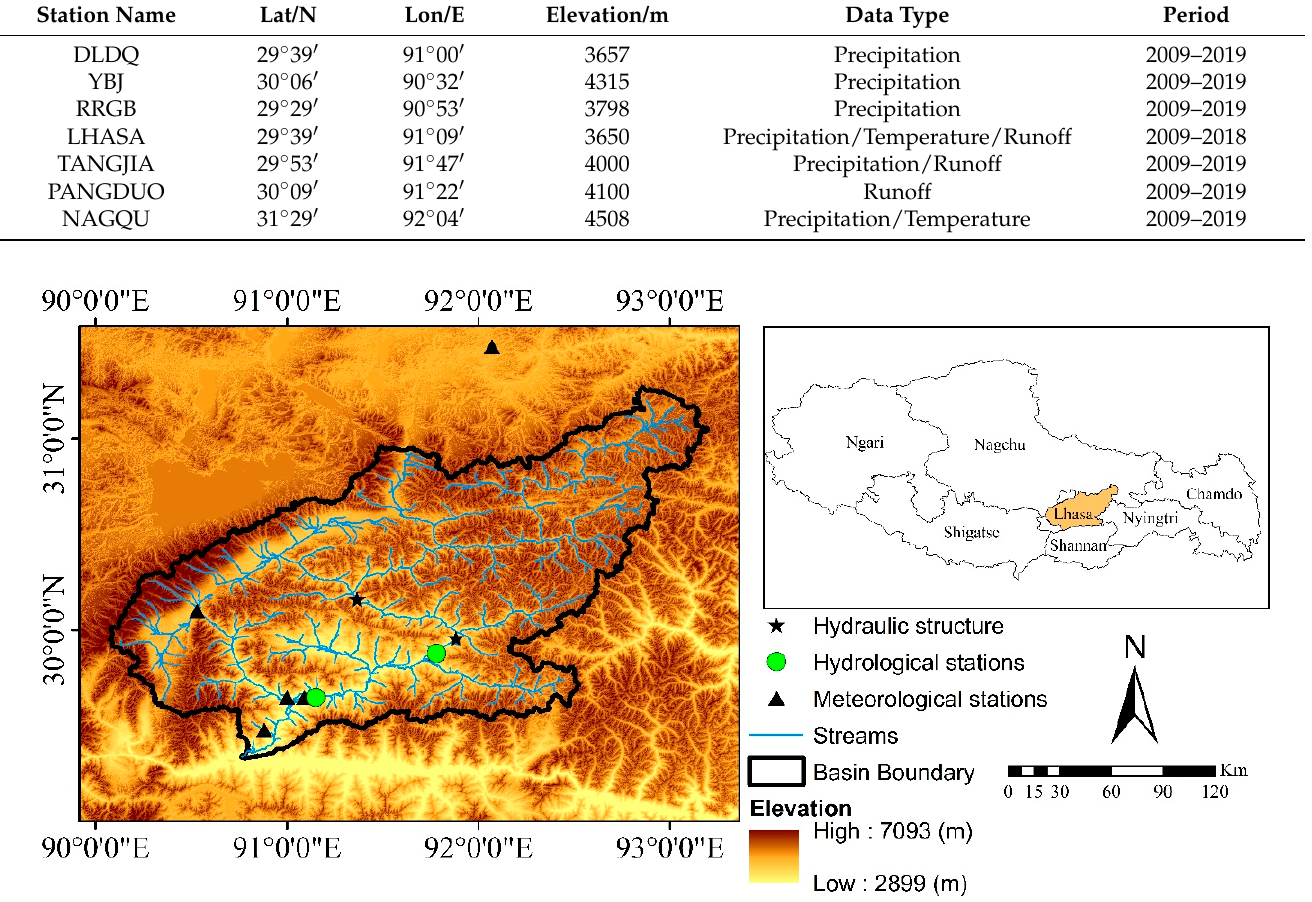
Figure 1. Geographical map of the Lhasa River Basin.